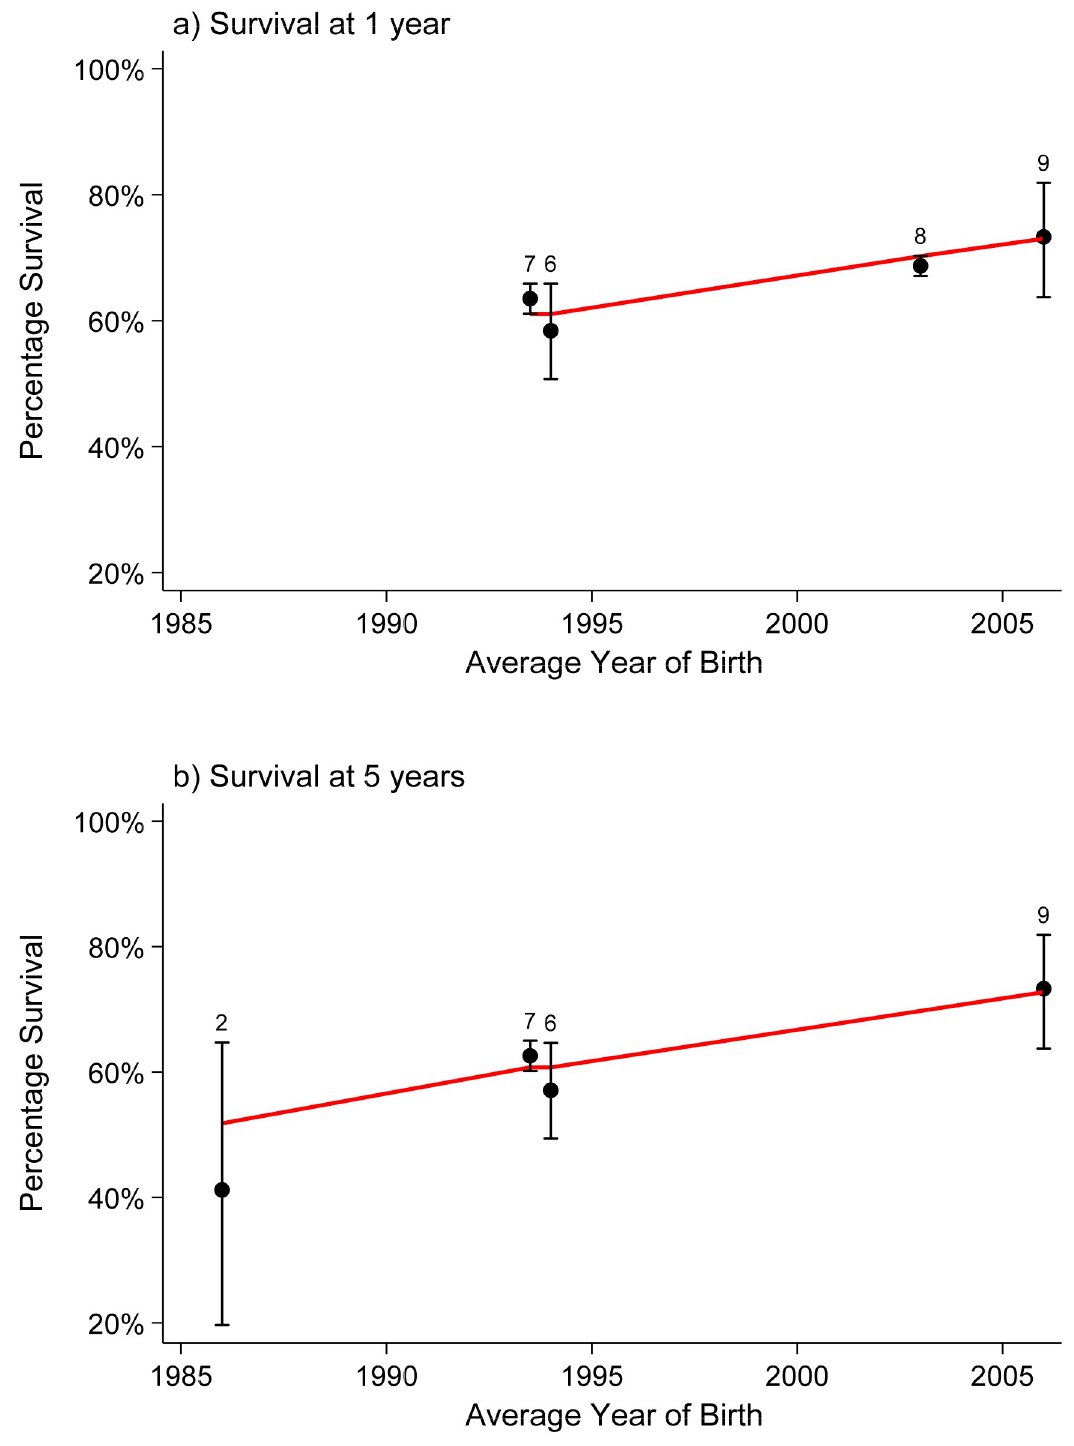
Fig 5. Survival estimates (with 95% confidence intervals) of children with congenital diaphragmatic hernia at 1 (a) and 5 (b) years of age over time (5 studies). The numbers at survival points indicate the included study: 2 –Garne, 2002, Denmark; 6 –Tennant, 2010, Northern England; 7 –Wang, 2011, USA; 8 –Wang, 2015, USA; 9 –Schneuer, 2019, New South Wales, Australia.